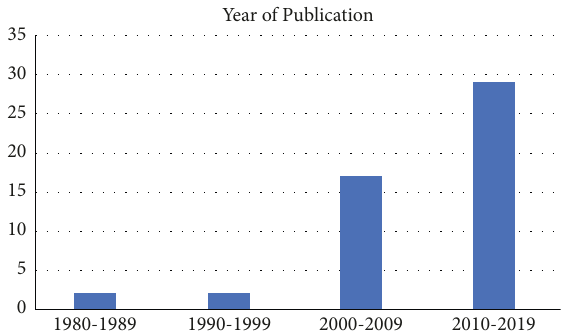
Figure 1: Journal articles published by